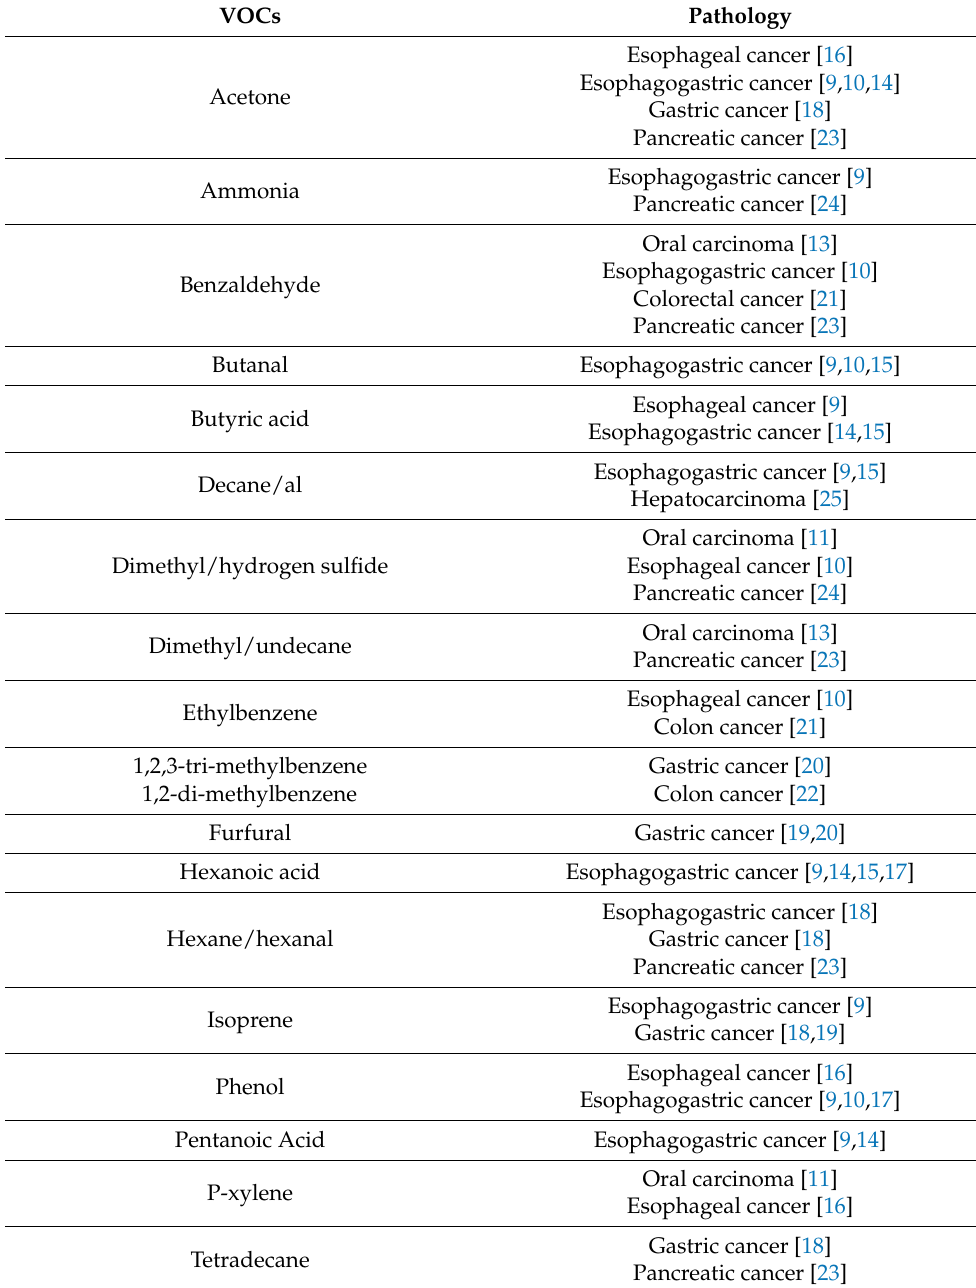
Table 3. Volatile organic compounds associated with digestive